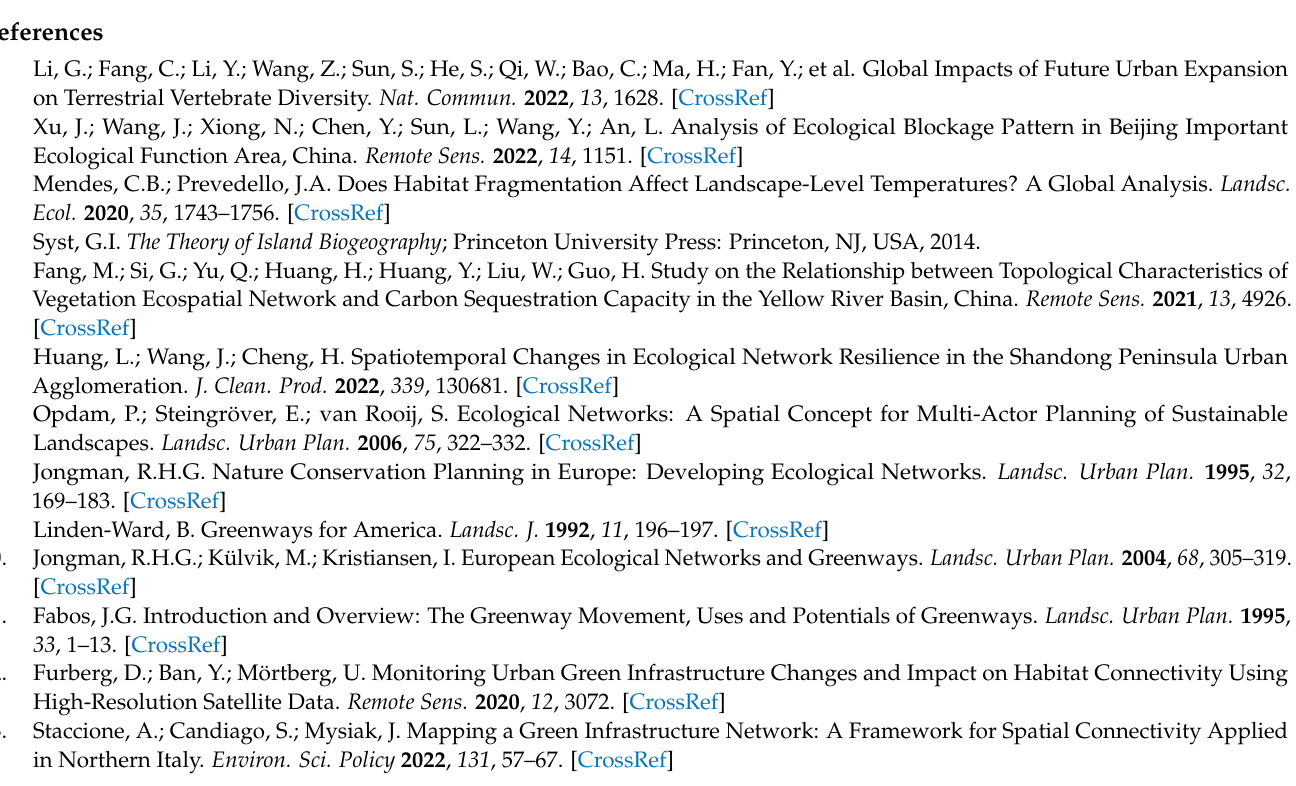
Figure A5. Verification of typical ecological pinchpoints in 2020.